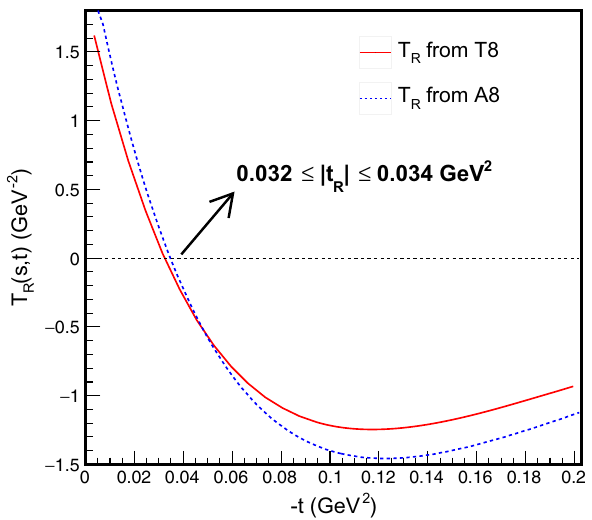
Fig. 4 Comparison of the real amplitudes in T8 (solid lines) and A8 (dashedlines)measurements.TheseamplitudesrepresentCondition(I), with all parameters free and phase φ ff . The (almost) coincidence of the zeros in T8 and A8 is remarkable